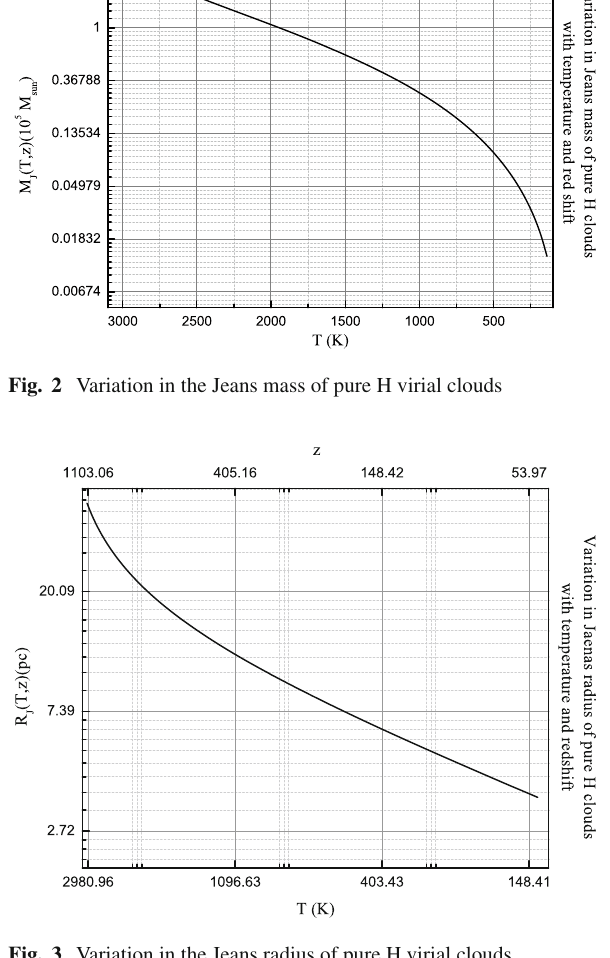
Fig. 3 Variation in the Jeans radius of pure H virial